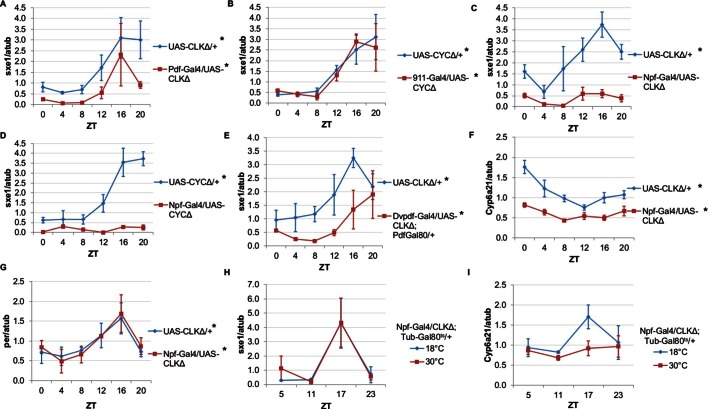
NPF-expressing clock neurons regulate rhythmic expression of fat body genes, sxe1 and Cyp6a21.(A, B) Ablating the molecular clock by expressing CLKΔ or CYCΔ in either the LNvs (Pdf-GAL4) (A) or DN1s (911-GAL4) (B) does not eliminate rhythmic sxe1 expression in the fat body. (C, D) Expressing CLKΔ (C) or CYCΔ (D) using Npf-GAL4 abolishes rhythmic sxe1 expression in the fat body. (E) Expressing CLKΔ in a subset of LNds (Dvpdf-GAL4;Pdf-GAL80) also does not eliminate cycling but reduces sxe1 expression in the fat body. (F) Npf-GAL4>UAS-CLKΔ abolishes rhythmic Cyp6a21 expression in the fat body. (G) per expression is rhythmic in flies expressing UAS-CLKΔ under Npf-GAL4. (H, I) CLKΔ expression in NPF cells is restricted to adulthood using Tub-GAL80ts. (H) sxe1 expression is not affected with adult-specific clock ablation in NPF cells. (I) Rhythmic Cyp6a21 expression is affected in the fat body when Npf-GAL4>UAS-CLKΔ expression is induced in adult at 30°C. Each experiment was repeated independently at least twice. The average value for each timepoint is plotted with error bars denoting SEM. JTK_cycle p value <0.05 is indicated by an asterisk (*) next to the genotype label. See Table 3 for JTK_cycle p values. ZT- Zeitgeber Time.DOI:
http://dx.doi.org/10.7554/eLife.13552.00910.7554/eLife.13552.010Figure 3—source data 1.Data for qPCR analysis of fat body clock-independent genes and clock genes in flies with ablated clock neurons.